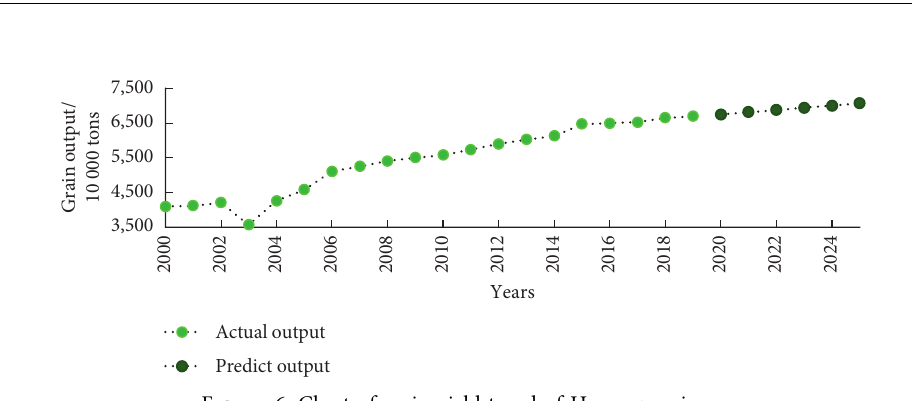
Figure 6: Chart of grain yield trend of Henan province.